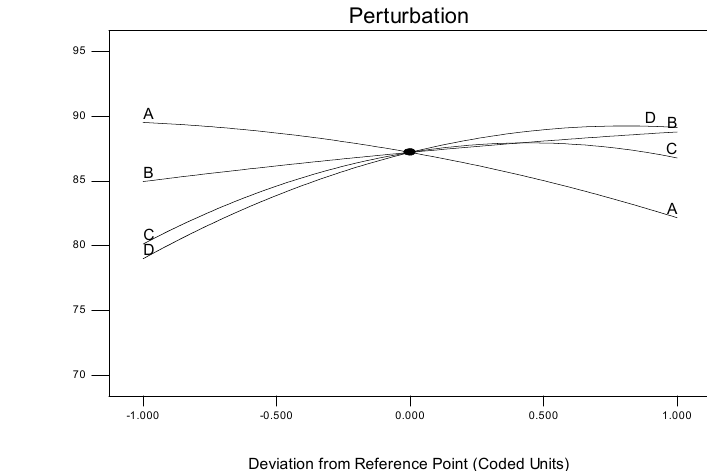
Figure 15. Perturbation plot of EV removal efficiency.